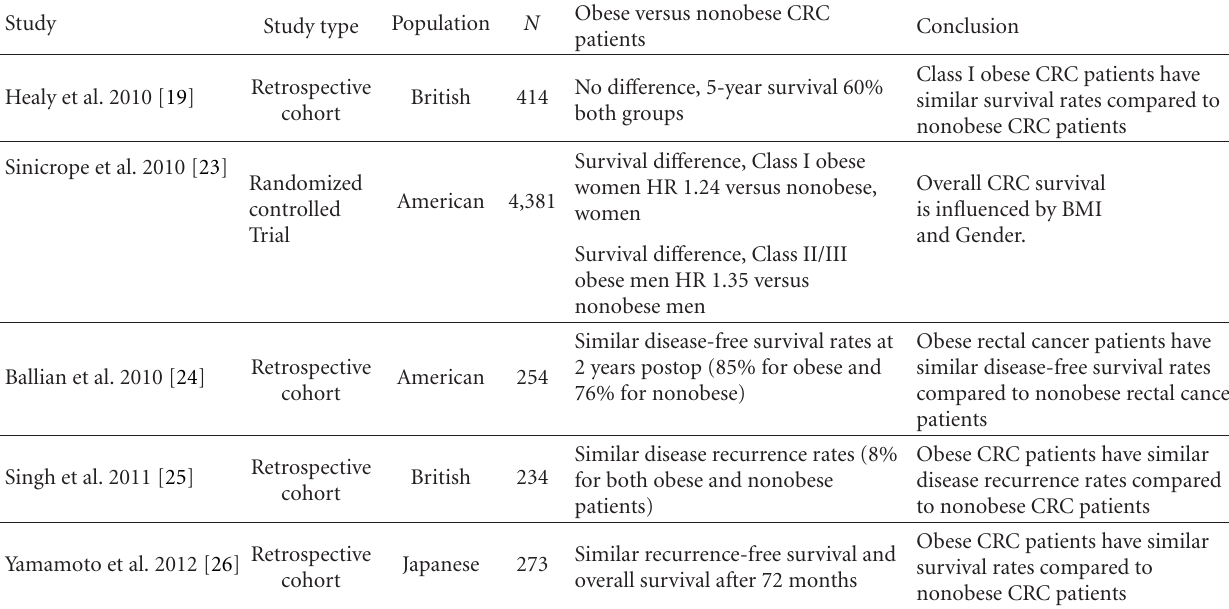
Table 2: Obesity and oncologic outcomes after CRC